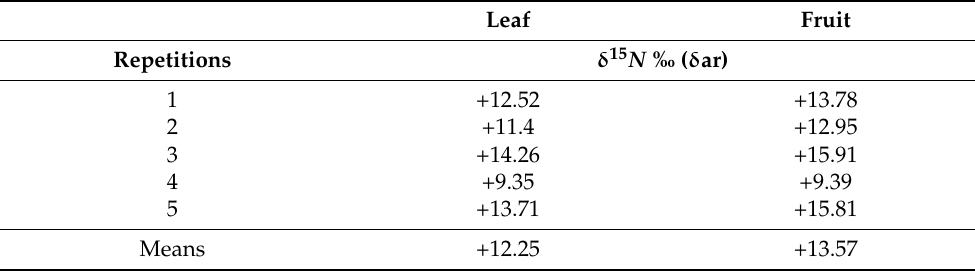
Table 3. Natural abundance 15 N of leaf and fruit of reference plant of cherry tomato.